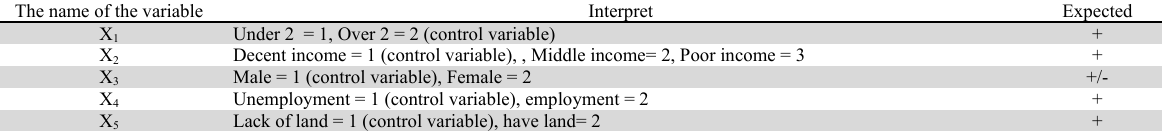
Interpreting variables in a regression model